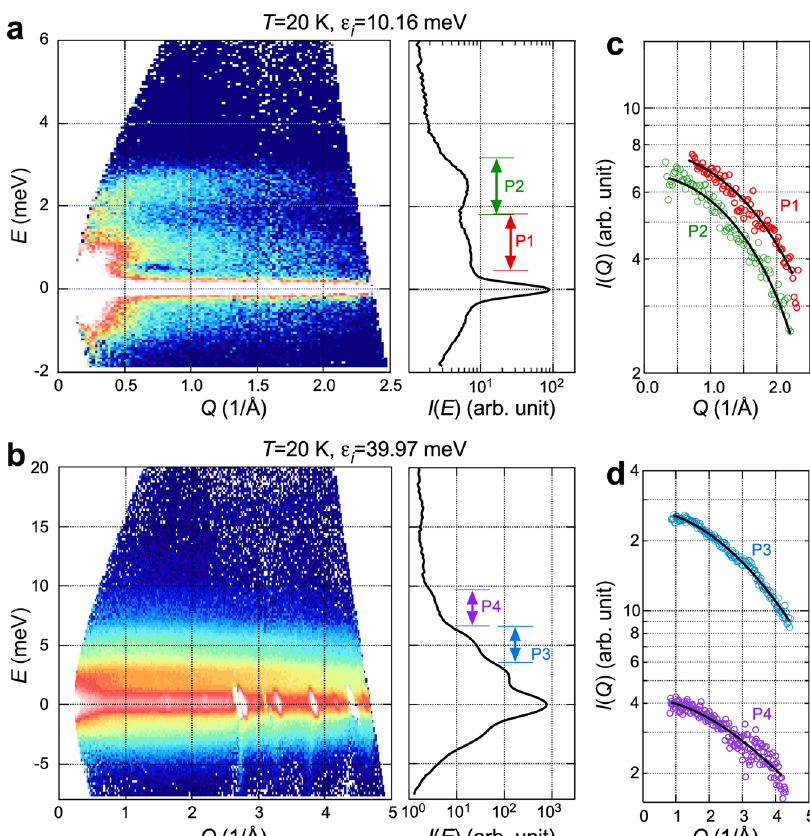
Fig. 2 Inelastic neutron intensity maps at T = 20 K in HoB 2 . INS intensity maps with the line pro fi le integrated along Q direction, I ( E ), measured at T = 20 K for the initial neutron energy of a ϵ i = 10.16 meV and b ϵ i = 39.97 meV. The Q dependence of the neutron intensity integrated along E -direction for c ϵ i = 10.16 meV and (d) ϵ i = 39.97 meV. The solid lines in ( c ) and ( d ) denote the curve of squared magnetic form factor, f 2 ( κ ), of Ho 3 +